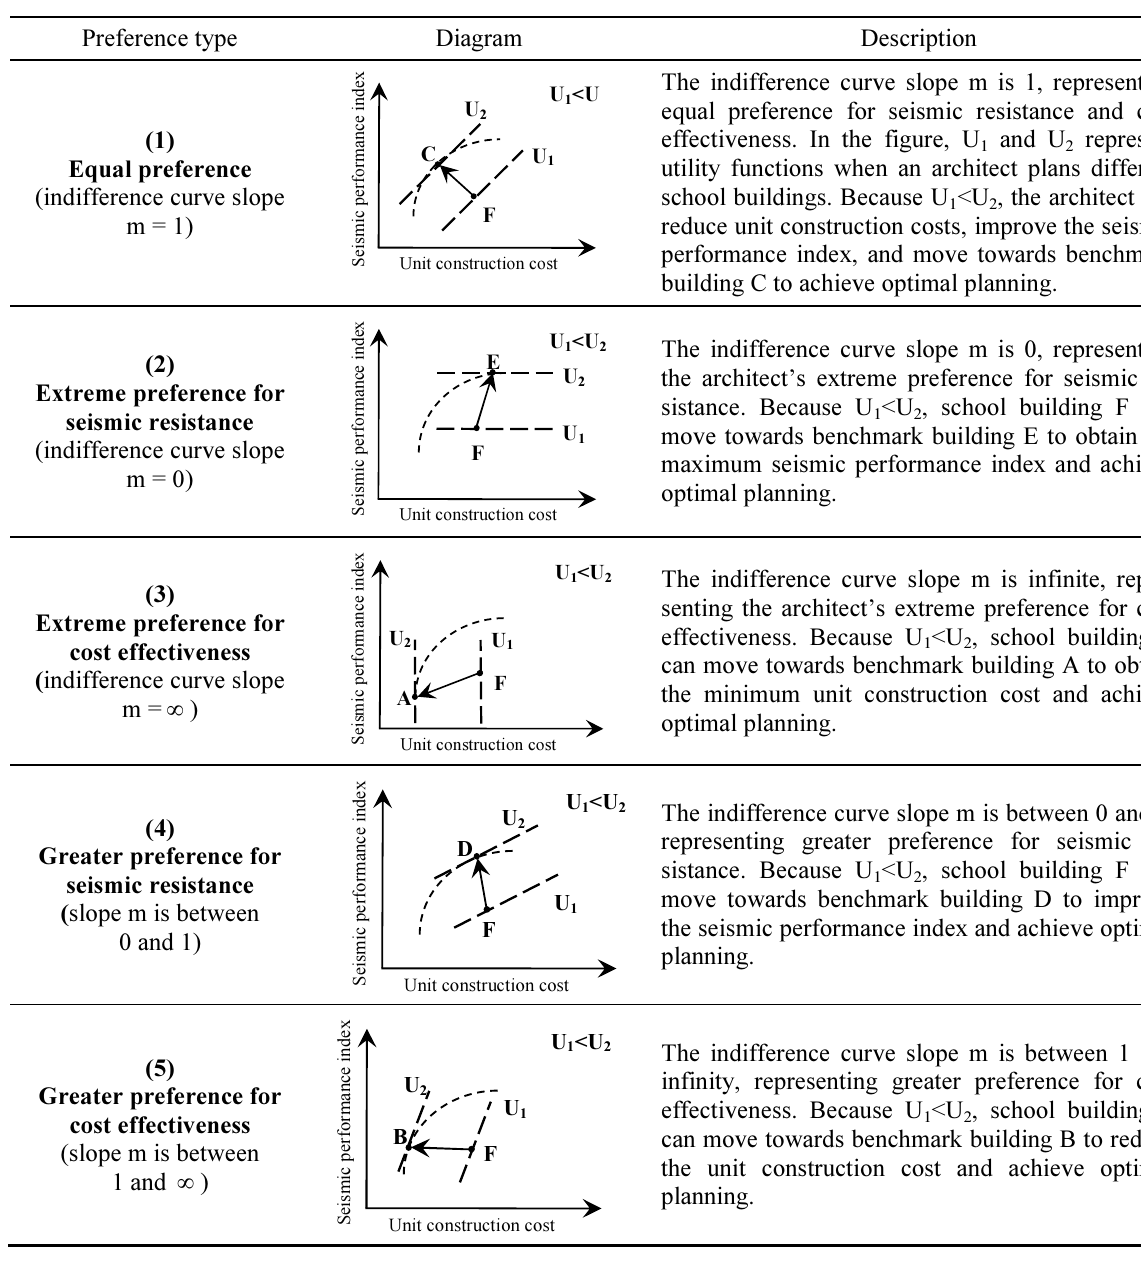
Table 1. Benchmarks for five planning preference